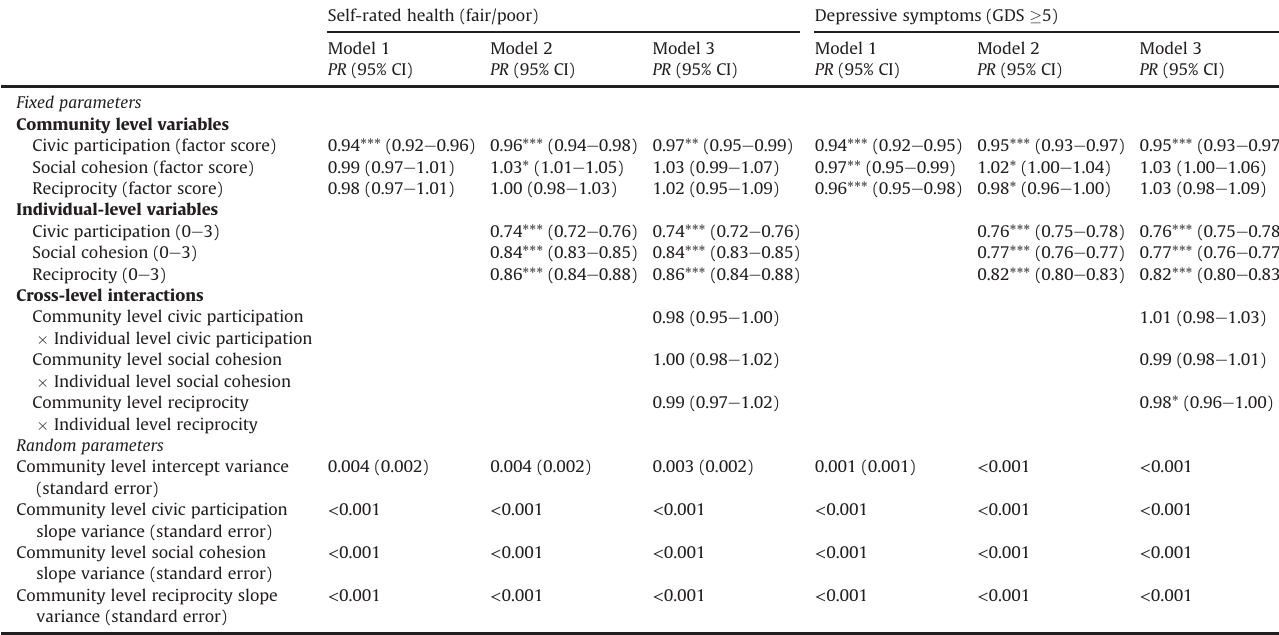
Table 5 Estimated prevalence ratios from multilevel Poisson regression